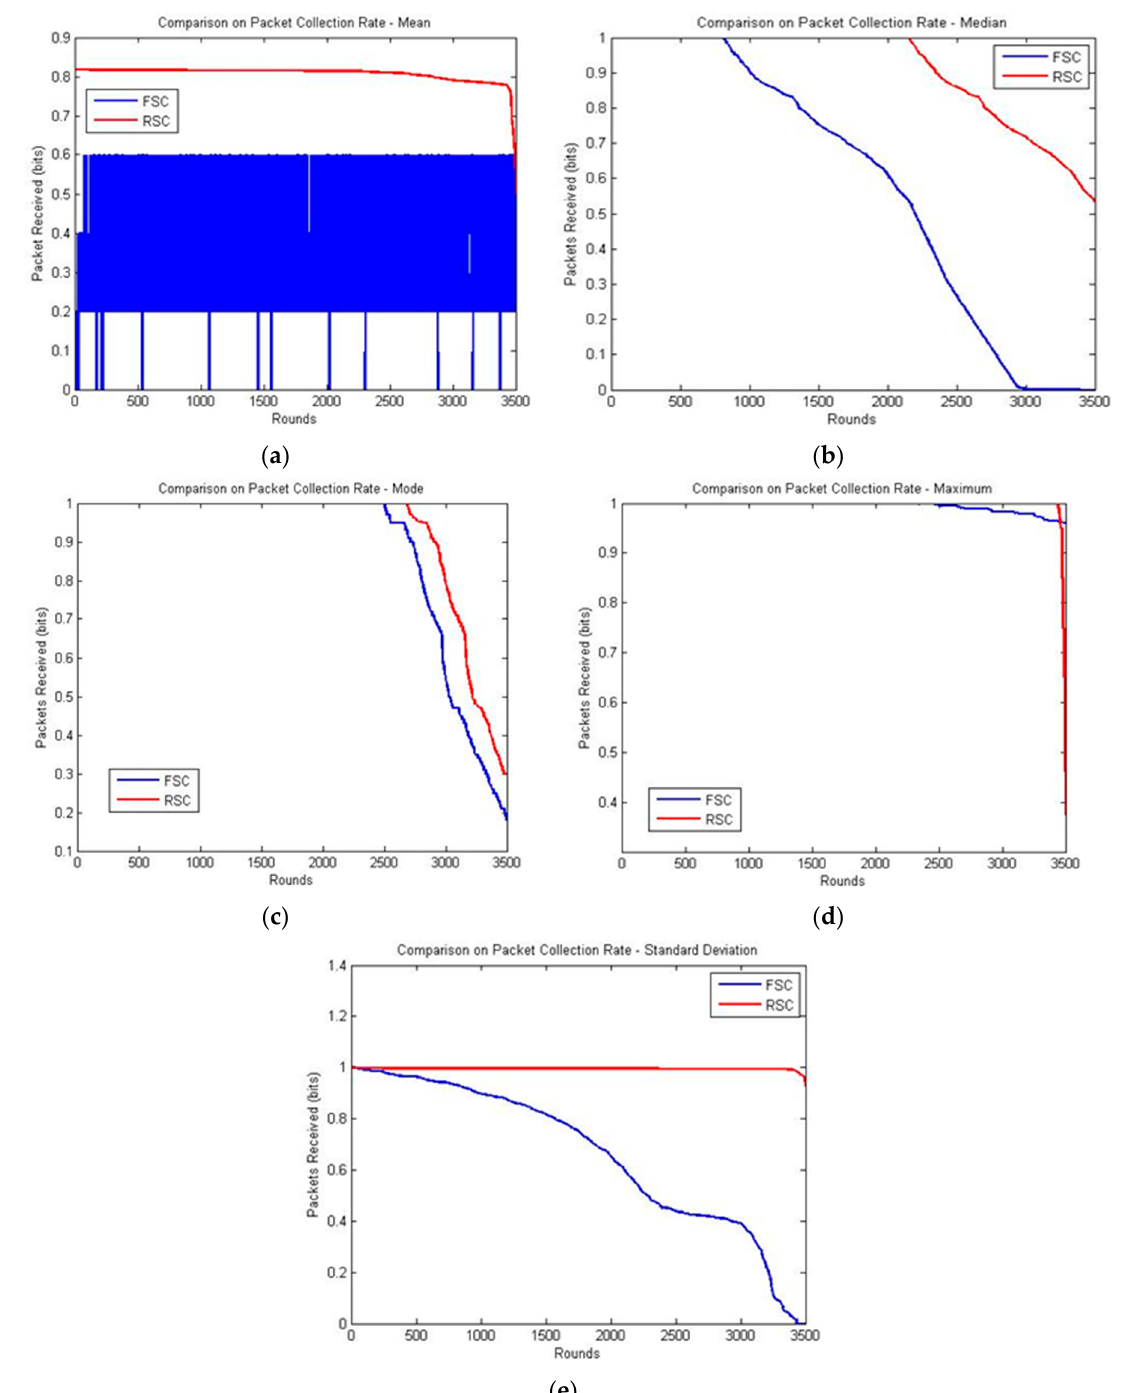
Figure 6. Comparison of the package collection rate: ( a ) mean; ( b ) median; ( c ) mode; ( d ) maximum; and ( e ) standard deviation.